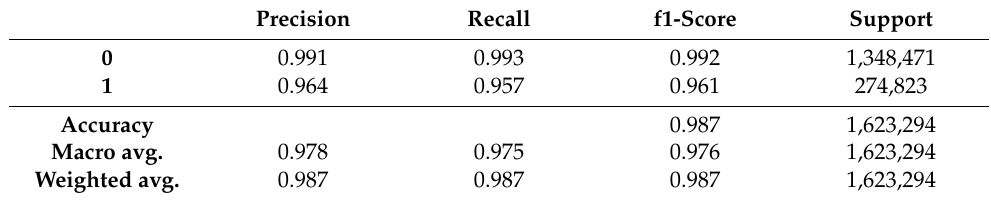
Table 9. Classification report of model after applying ensemble technique with random forest.